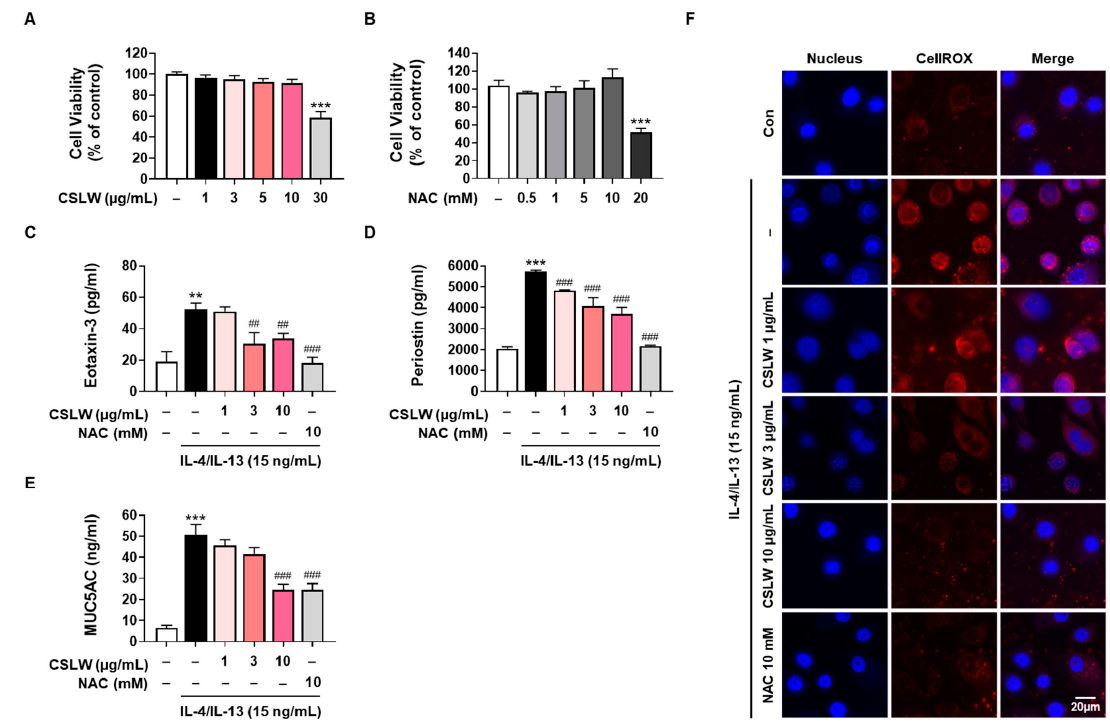
Figure 6. Effect of CSLW on IL − 4/IL − 13 − induced eotaxin-3, periostin, and MUC5AC expression via intracellular ROS production in primary HNEpCs. ( A , B ) HNEpCs were treated with the indicated concentrations of CSLW or NAC and incubated for 24 h, and cell viability was evaluated using the MTS assay. Cells were treated with CSLW (1, 3, or 10 μ g/mL) or NAC (10 mM) under IL − 4/IL − 13 (15 ng/mL) − stimulated medium for 24 h ( C – E ) or 1 h ( F ). ( C – E ) Eotaxin-3, periostin, and MUC5AC levels in the cell culture supernatant were evaluated using an ELISA kit. ( F ) Analysis of intracellular ROS production levels in IL − 4/IL − 13 − stimulated HNEpCs. Cells were stimulated with IL − 4/IL − 13 (15 ng/mL) under the CSLW or NAC (the latter was used as a positive control) treatment conditions mentioned above and then incubated with the intracellular ROS indicator CellROX and detected via confocal microscopy. The data are presented as the means values ± SD; ** p < 0.01 and *** p < 0.001 compared with the control cells; ## p < 0.01 and ### p < 0.001 compared with the IL − 4/IL − 13 − treated cells. CSLW, Caesalpinia sappan Linn. heartwood water extract; IL, interleukin; NAC, N -acetyl- L -cysteine; ROS, reactive oxygen species.